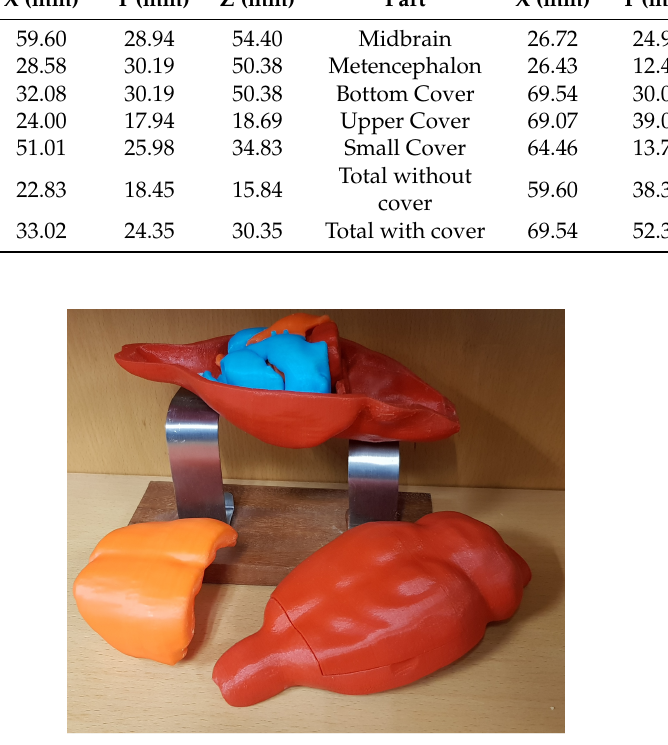
Figure 7. Final 3D model of the rat